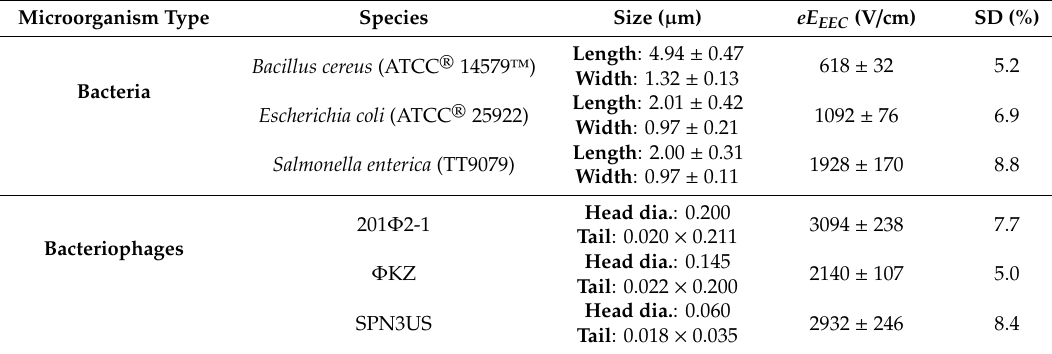
Table 1. List of all the microorganisms used in the study, along with their eE EEC and the standard deviation. All eE EEC values were estimated from experimental